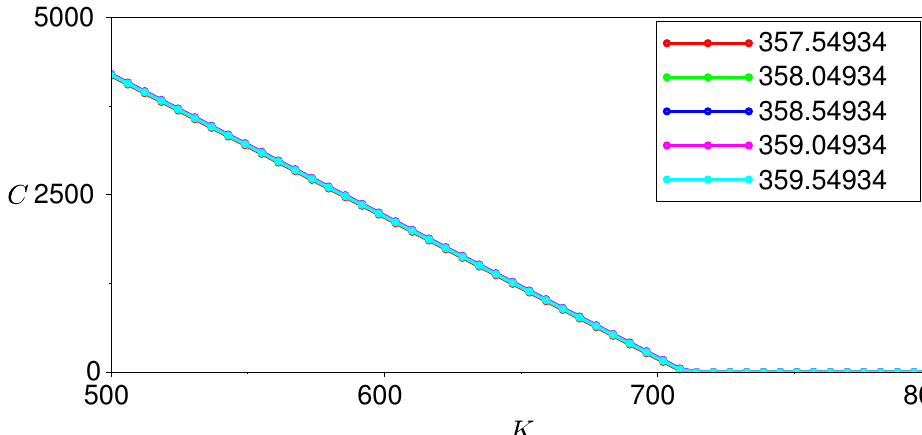
Figure 8. Option prices for varying values of a .